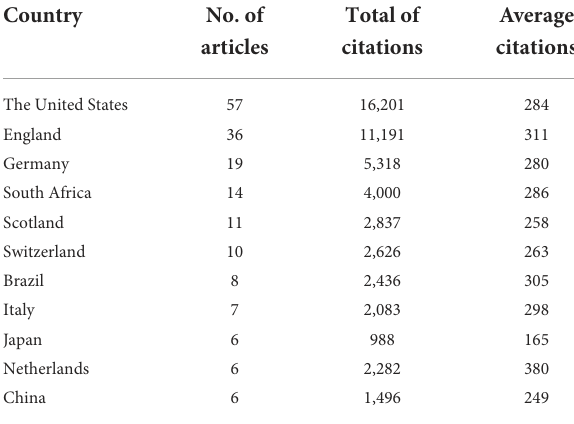
TABLE 1 Top 10 countries of origin of the 100 most-cited SARS-CoV-2 variant articles. Country